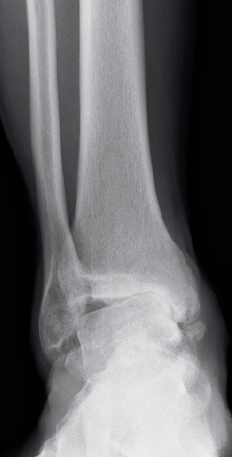
Figure 2. ”Ligamentary ankle OA”, advanced asymmetrical ankle OA secondary to chronic unsolved lateral instability.